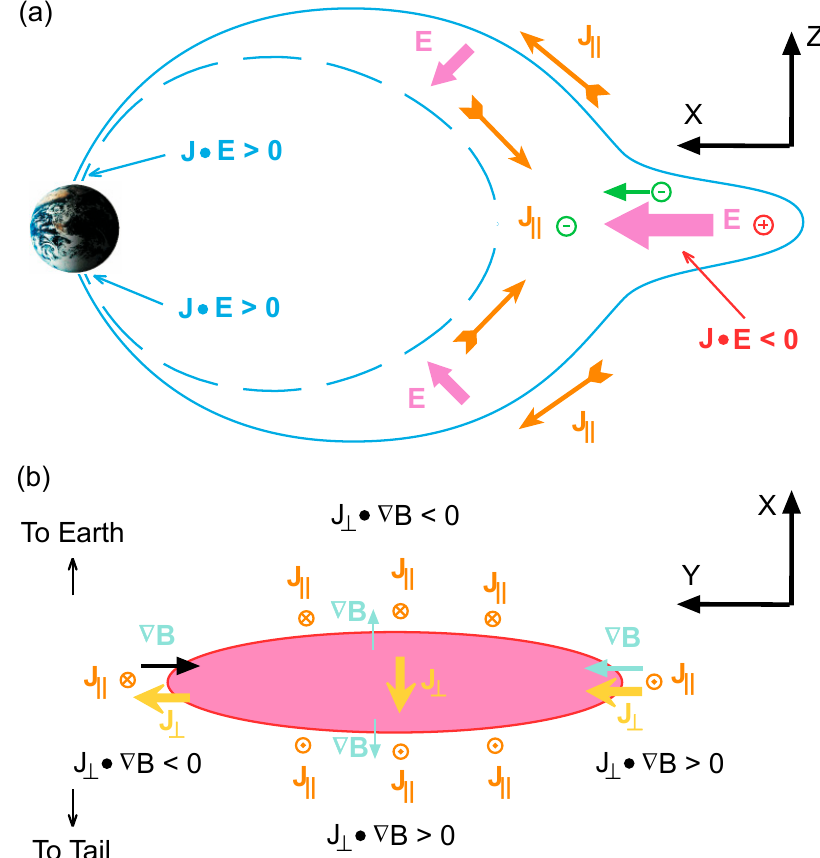
Figure 8. The CCI disturbance generates a condition showing opposite signs of J ⊥ and ∇ B on the west and east sides of the CD ( a ), and based on Equation (2), opposite signs of FACs are produced to produce the periodic bead structure in the ionosphere ( b